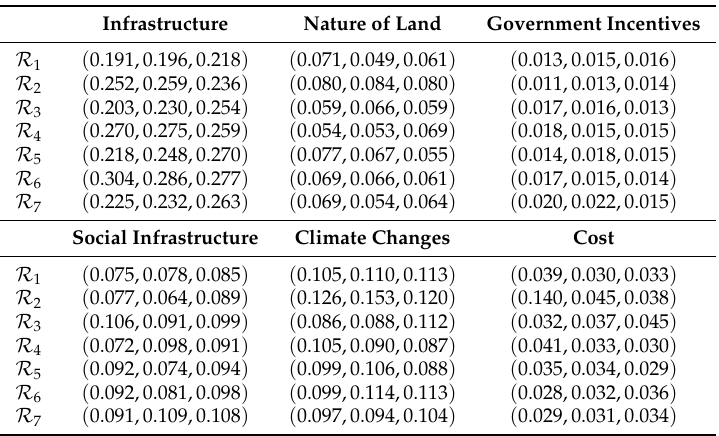
Table 18. Weighted aggregated decision